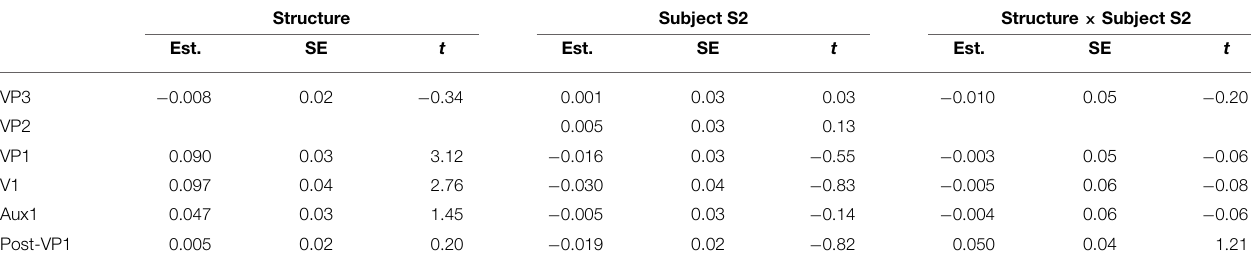
TABLE 4 | Fixed effects of mixed-effect models for reading times in experiment